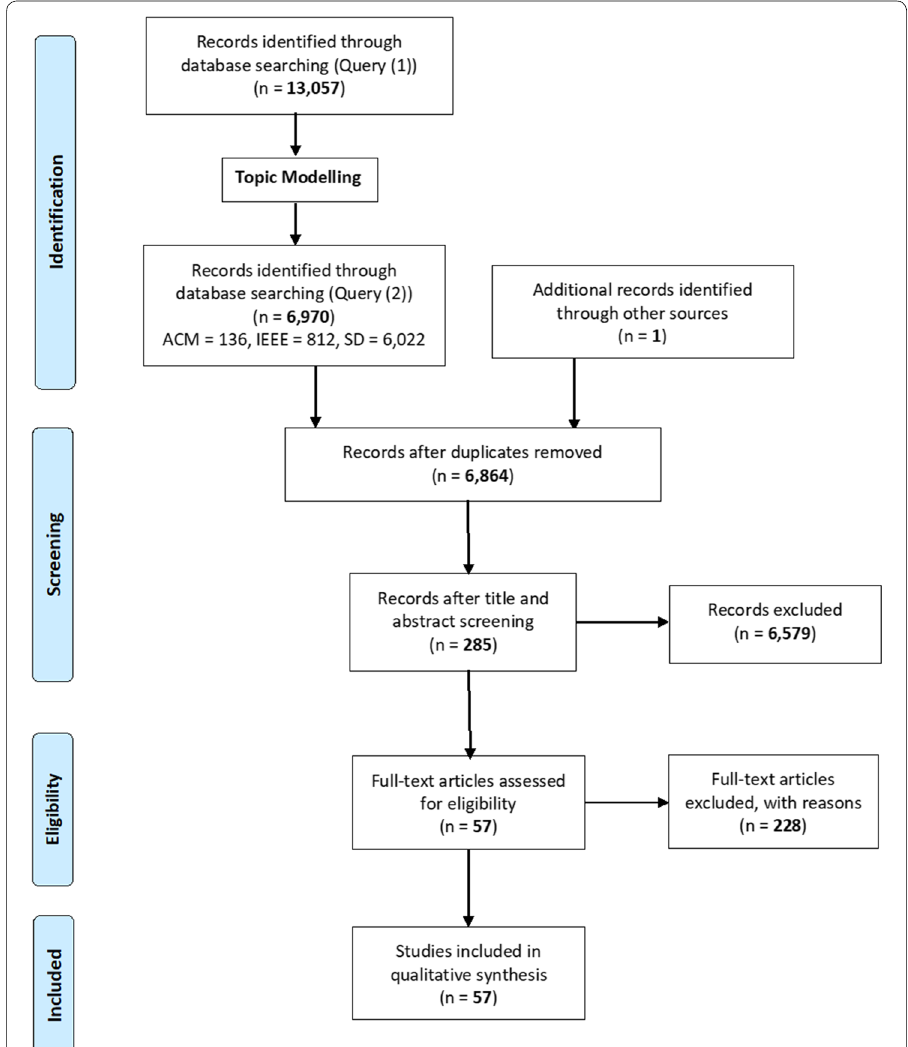
Fig. 3 PRISMA flow diagram. Extended PRISMA flow diagram visualizing the selection process starting from the 13,057 publications from the initial topic model to the 6970 publications obtained from search query (2) and the subsequent selection process resulting in the final number of 57 considered